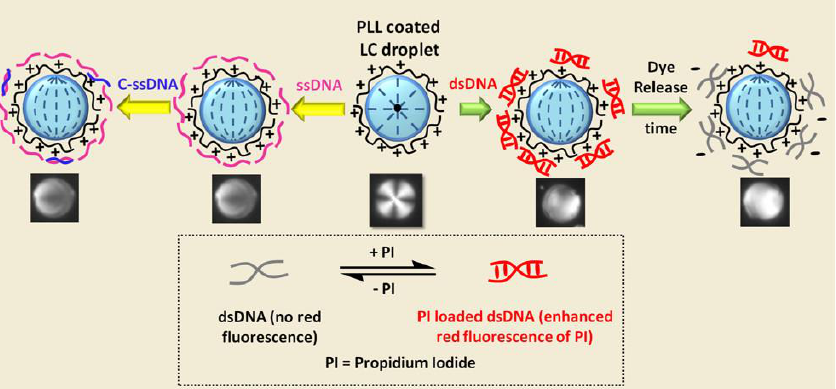
Figure 5. Schematic illustrations of poly(L-lysine)-coated LC droplets for sensitive detection of DNA and their applications in controlled release of drug molecules. Reprinted with permission from ref. [94]. Copyright 2017 American Chemical Society.